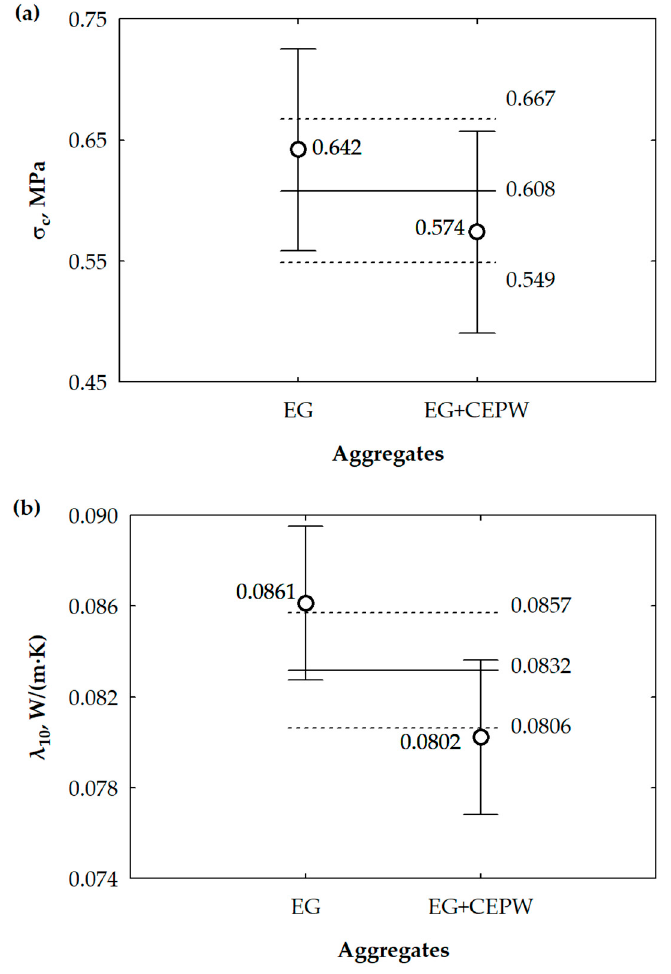
Figure 3. Analysis of the effect of CEPW on compressive strength ( a ) and thermal conductivity ( b ). The average values obtained for compressive strength meet the 95% confidence limits, and this indicates that the replacement of part of the EG aggregate with the CEPW aggregate does not affect the compressive strength (or that the influence is insignificant). In the second case, the thermal conductivity results were evaluated (Figure 3b). The analysis of the results showed that the use of CEPW aggregate affects the reduction of thermal conductivity. The average values of the thermal conductivity measurements obtained are not within the range and this means that the results of the specimens made with only EG aggregate, and the specimens with partially replaced aggregate from CEPW, differ significantly. With CEPW, we achieved our goal of significantly reducing thermal conductivity with little or no reduction in compressive